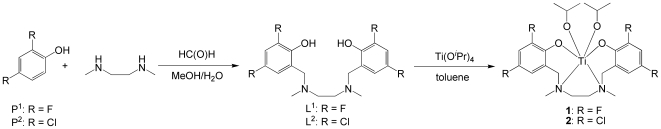
Synthesis of the salan ligands and titanium salan complexes.The halo-salan ligands L1 and L2 were synthesised via a Mannich-condensation of the respective phenol, formaldehyde and N,N'-ethylenediamine. The ligands were then metallated with Ti(OiPr)4 in toluene to give complexes 1 and 2.